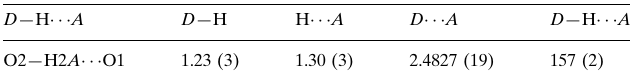
Hydrogen-bond geometry (A˚ , (cid:2)